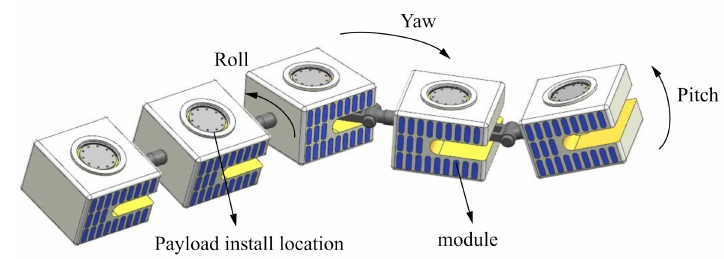
Figure 1. Model of SMSRS with five